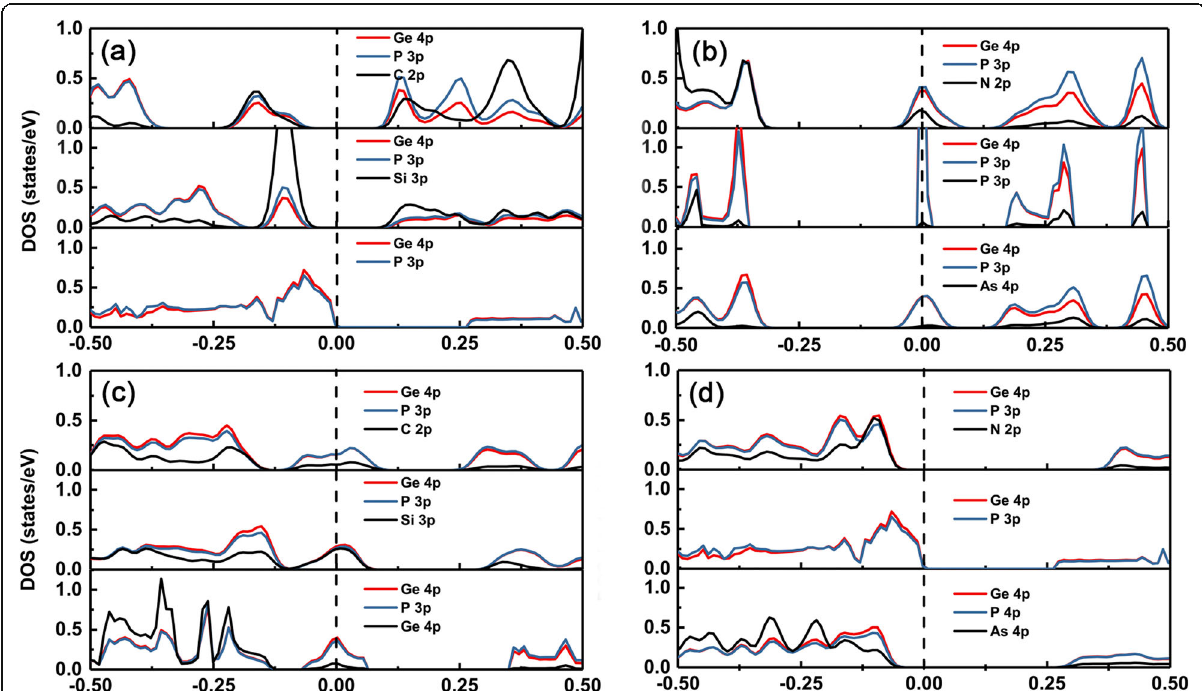
Fig. 5 DOS for the doped systems. The partial density of states (right) for group IV (C, Si, and Ge) and group V (N, P and As) atoms doped GeP 3 . The vertical blacked dashed line is the Fermi level. (a) and (b) substituted Ge atom, (c) and (d) substituted P